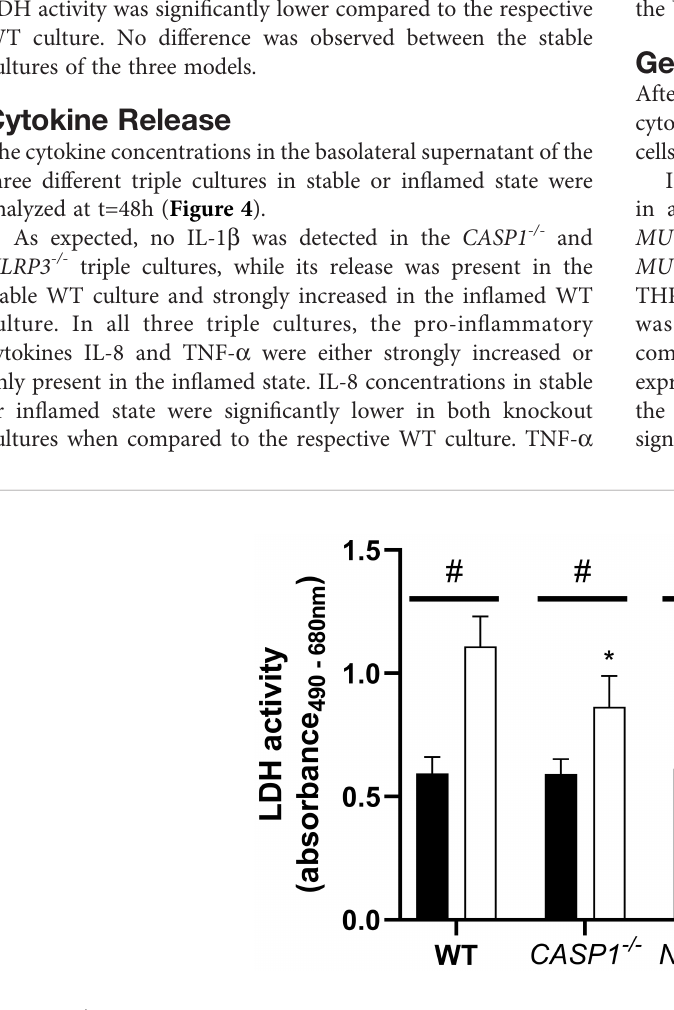
FIGURE 3 | LDH activity in the apical compartment after 48 h of triple culture with WT, CASP1 -/- or NLRP3 -/- THP-1 cells. Mean + SD of N = 3. *p < 0.05 compared to the respective WT triple culture, # p < 0.05 compared to the respective stable culture.